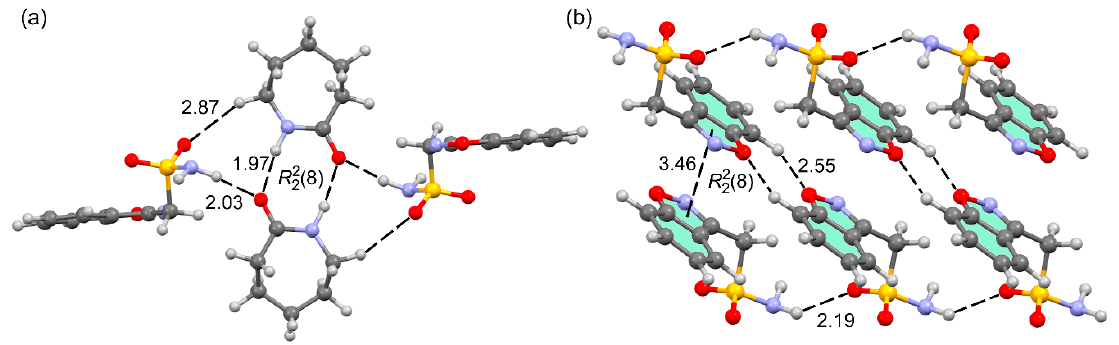
Figure 8. ( a ) Partial view of the cocrystal showing the H-bonding dimer of ϵ -caprolactam and two appended zonisamide molecules. ( b ) 1D supramolecular chains of H-bonded zonisamide molecules connected by R 22 (8) synthons and π -stacking interactions. Distances in Å.